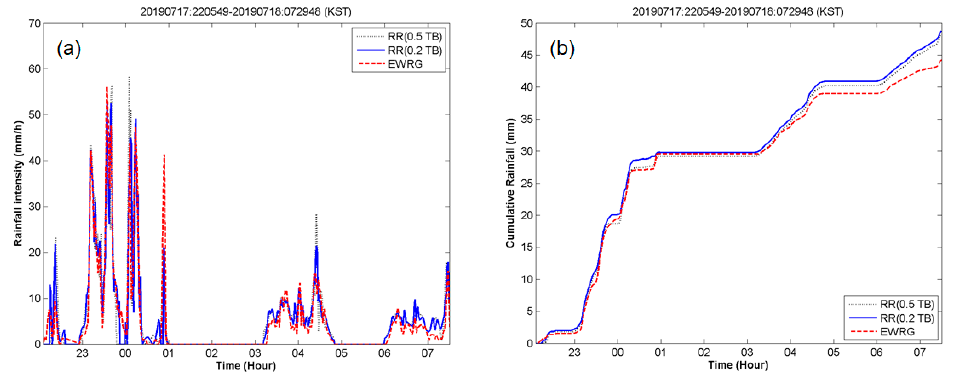
Figure 11. Comparison between rainfall obtained by the EWRG and rain gauges for event 1. ( a ) EWRG average rainfall (mm / h) and rain gauge rainfall (mm / h); ( b ) cumulative EWRG average rainfall (mm) and cumulative rain gauge rainfall (mm). The red dotted line is the average rainfall of the EWRG, and the solid blue line and the black dotted line are rainfall measured by the tipping bucket rain gauges (0.2, 0.5), respectively.